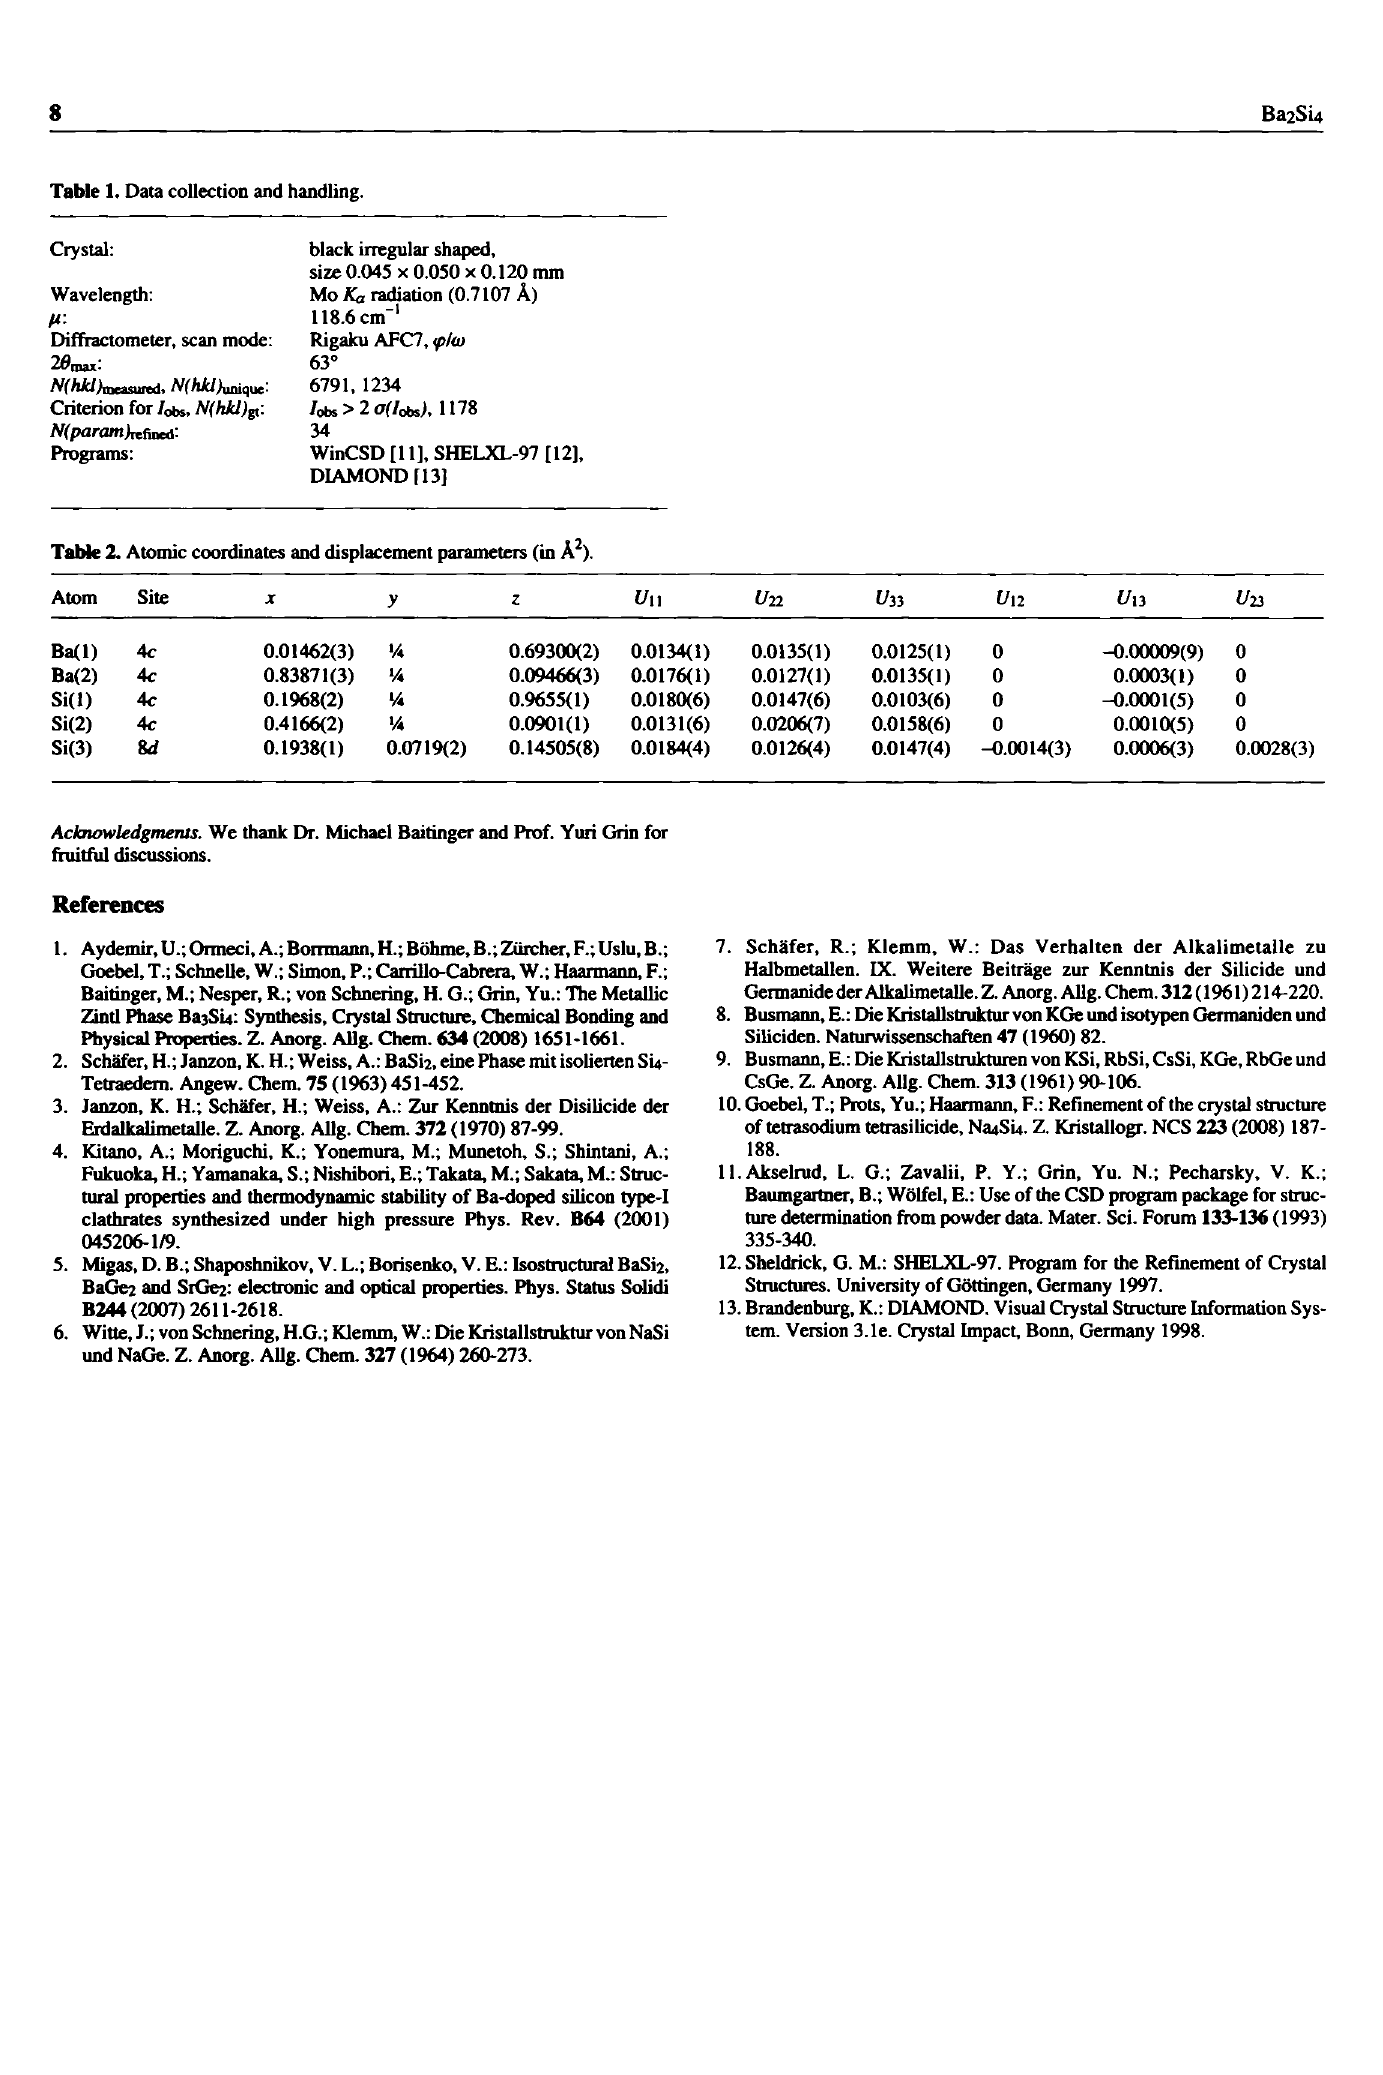
Table 1. Data collection and handling.